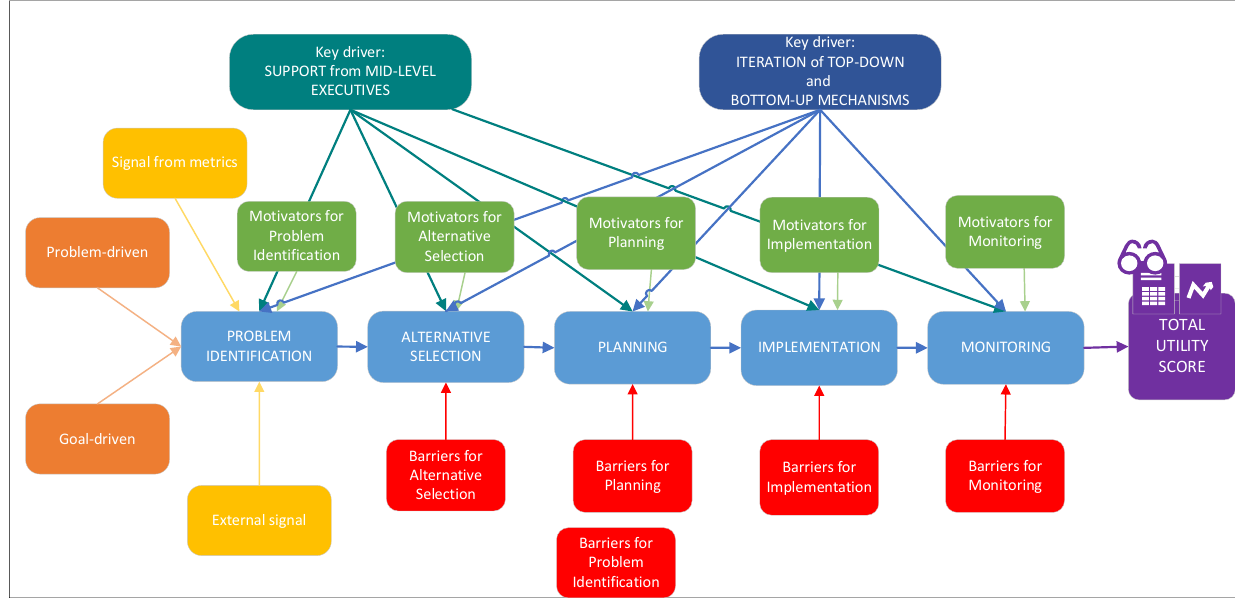
Figure 4. Decision tree structure for formal social units.